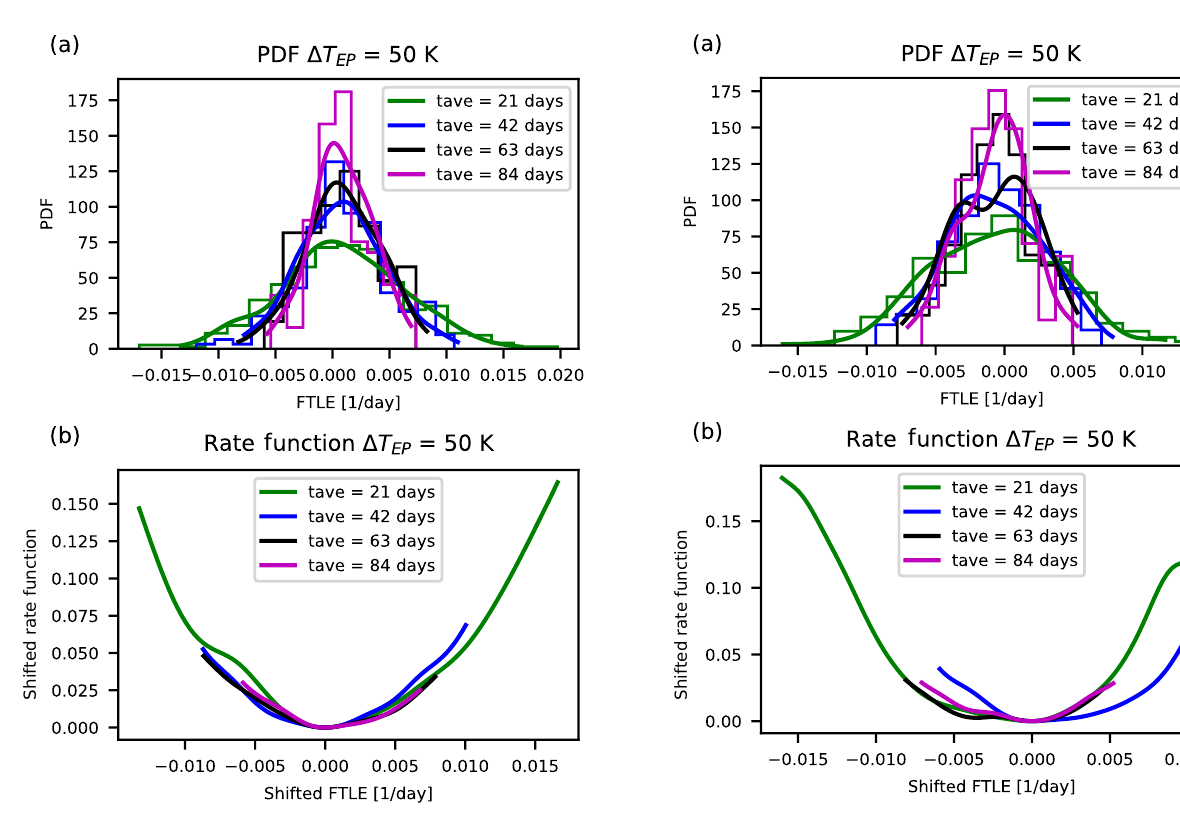
Figure 6. Distributions and rate functions of λ 59 , a near-zero, grow- ing instability in PUMA, for (cid:49)T EP = 50K. Panels as in Fig. 2.